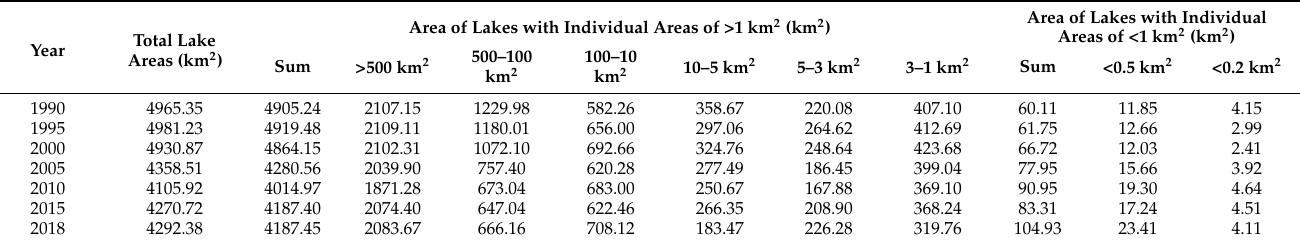
Table 1. Changes in lake area in Inner Mongolia during 1990–2018.